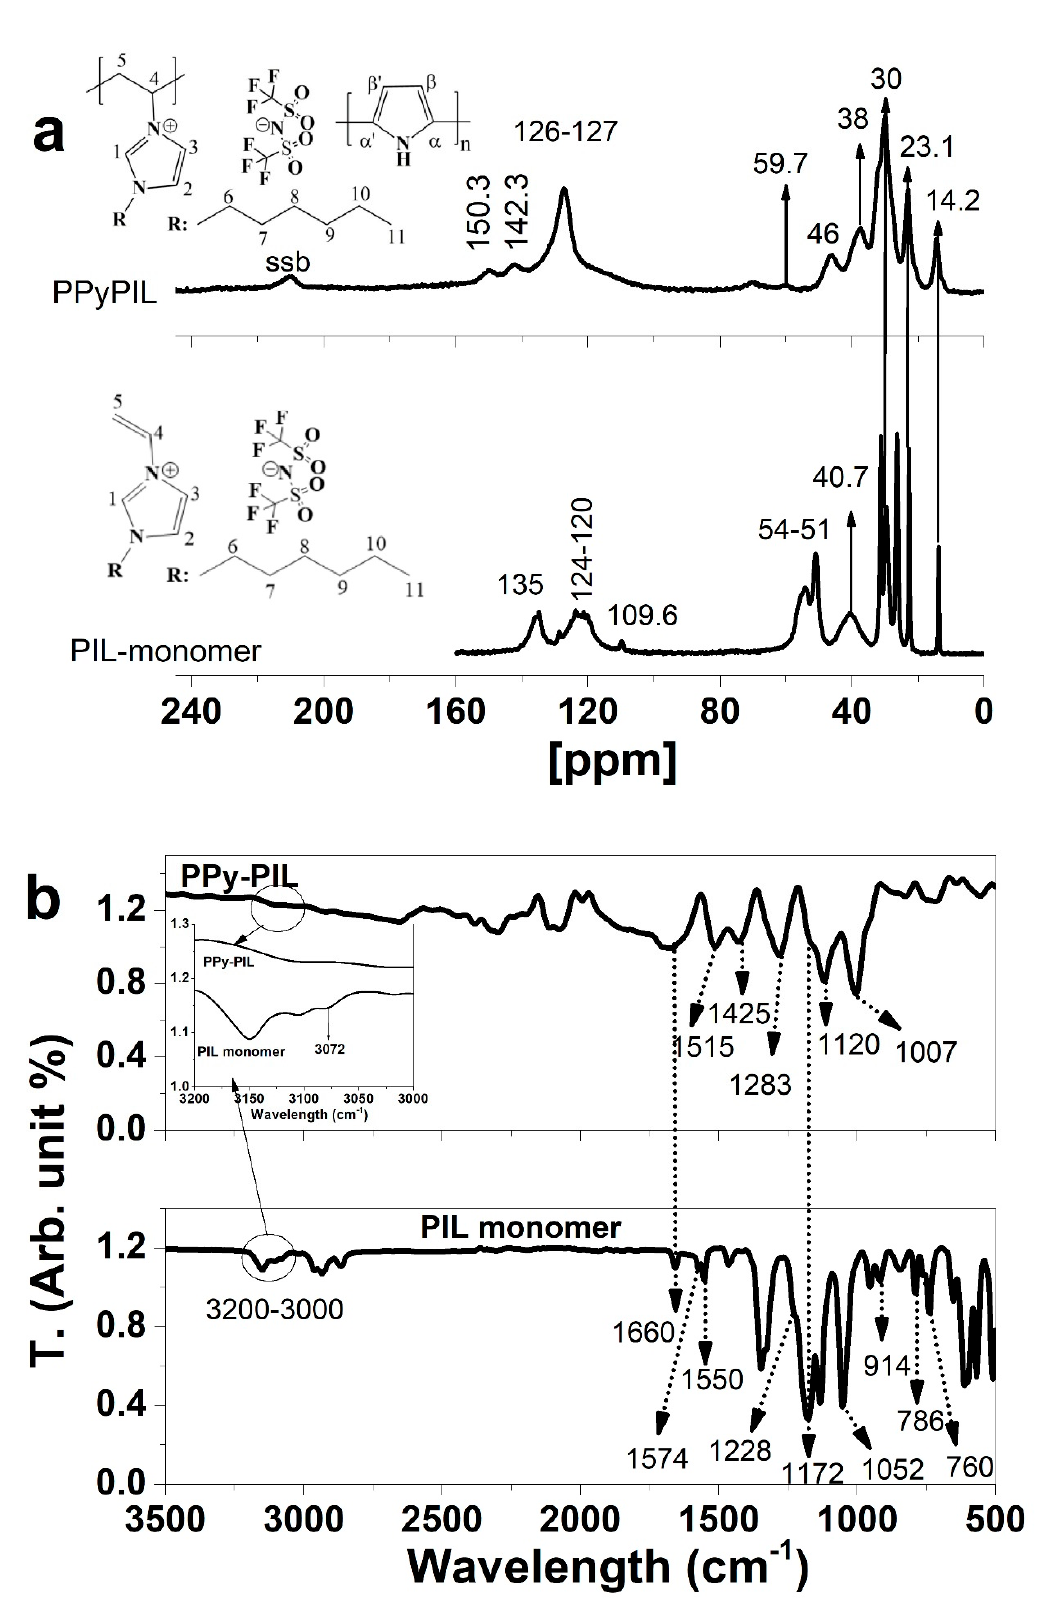
Figure 2. 13 C MAS-NMR spectra of electropolymerized PPyPIL with spinning side bands (ssb) and the PIL monomer are presented in ( a ). FTIR spectra of PPyPIL and PIL monomer (3500–500 cm − 1 ) with inset of the 3200–3000 cm − 1 are shown in ( b ).